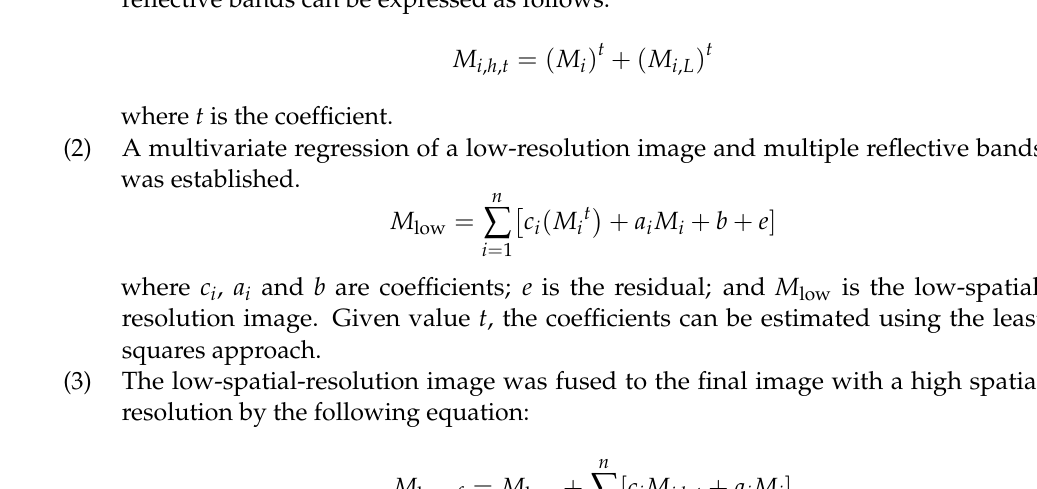
Figure 6. The reflectance curve of time-series image of a forest stand. ( a ) A forest stand. ( b ) The average reflectance of a forest stand for each band. ( c ) The reflectance curve across the stacked time-series bands. For the LiDAR data, the profile curve for each stand was generated to extract the structural features of forest stands. The profile curve was generated from the vertical fre- quency distribution of the LiDAR data. The profile curve is essentially a histogram of height. Since this curve can characterize the vertical structure of trees, we use the term profile curve. The same tree species have similar structural features, and different tree species have different structural characteristics, as illustrated in Figure 7. Figure 8 shows the profile curve extracted in a forest stand. The steps for generating the profile curve are described as follows. First, the elevation was uniformly discretized, and the value of each elevation interval was calculated. In this study, N was set to 100. The number of point clouds contained in each discrete height interval of each forest stand was calculated, and the vertical profile curve of the point cloud was generated. Finally, after being divided by the total number of point clouds in this forest stand, the profile curve was obtained. The x -axis in Figure 8 is the height bin, and the y -axis is the frequency distribution of the point cloud. The average point number in a stand is 2687, thus the generated curves are rather smooth.